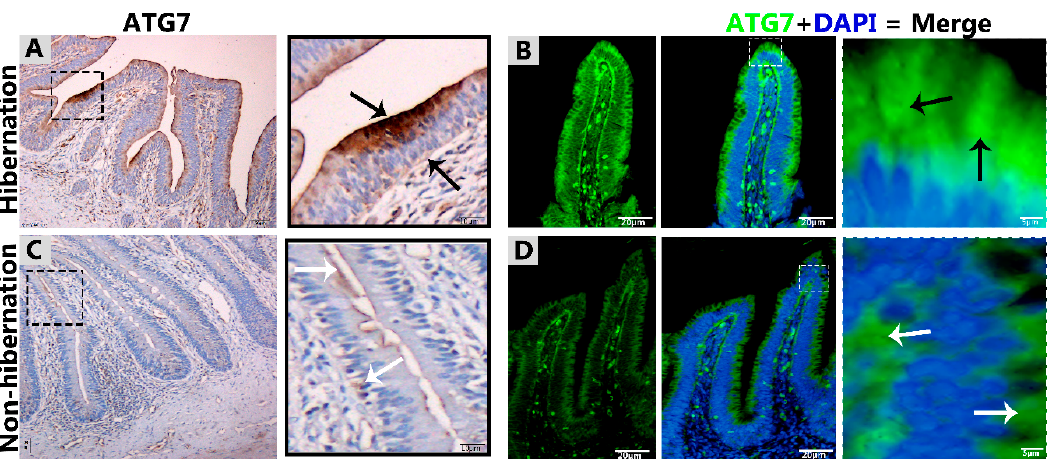
Figure 1. Immunohistochemistry and immunofluorescence staining of ATG7 in the mucosal surface of the small intestine of Pelodiscus sinensis. During hibernation ( A , B ) and nonhibernation ( C , D ), there were strong, positive (black arrow) and weak expressions (white arrow). Scale bar = 50 µm ( A , C ) and 20 µm ( B , D ).